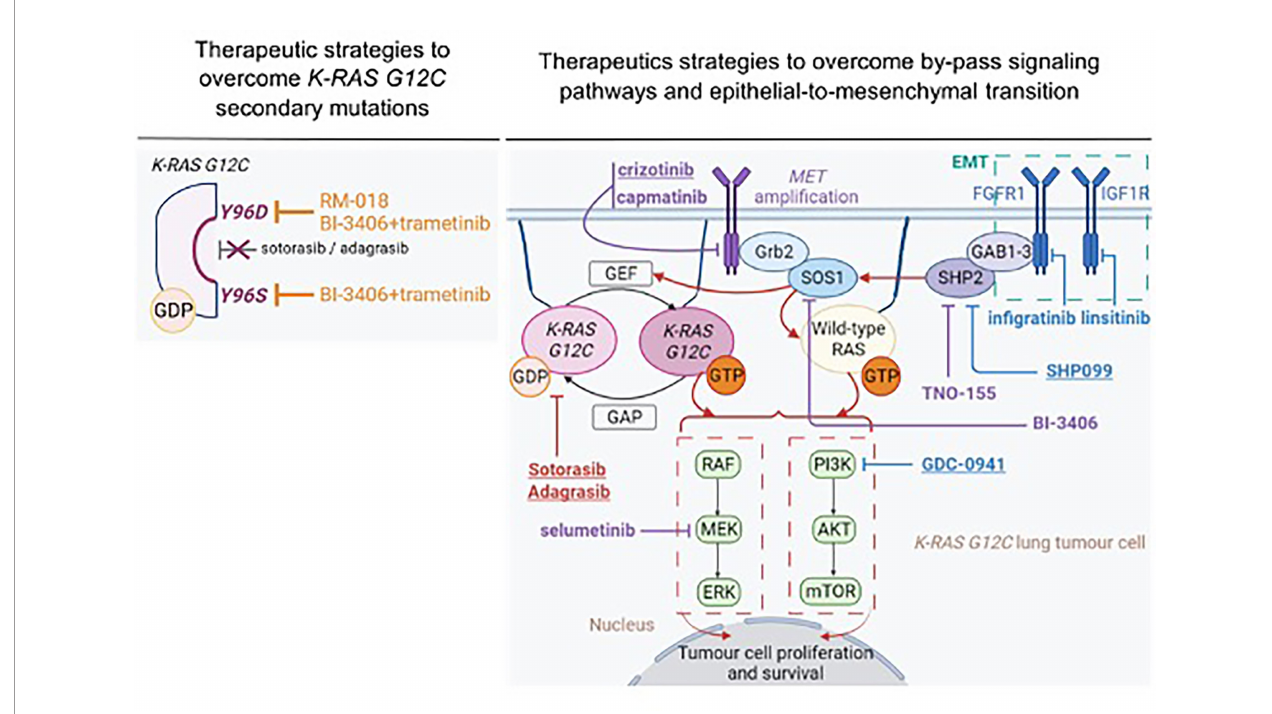
FIGURE 3 | Therapeutic strategies to overcome acquired resistance to sotorasib and adagrasib. Treatment that demonstrated therapeutic ef fi cacy in both in vitro and in vivo setting are underlined. Therapeutic strategies that demonstrated ef fi cacy in pre-clinical specimens in the context of acquired resistance related to MET ampli fi cation are represented in purple. Therapeutic strategies that demonstrated ef fi cacy in pre-clinical specimens in the context of acquisition of epithelial-to- mesenchymal features are represented in blue. This fi gure was created with